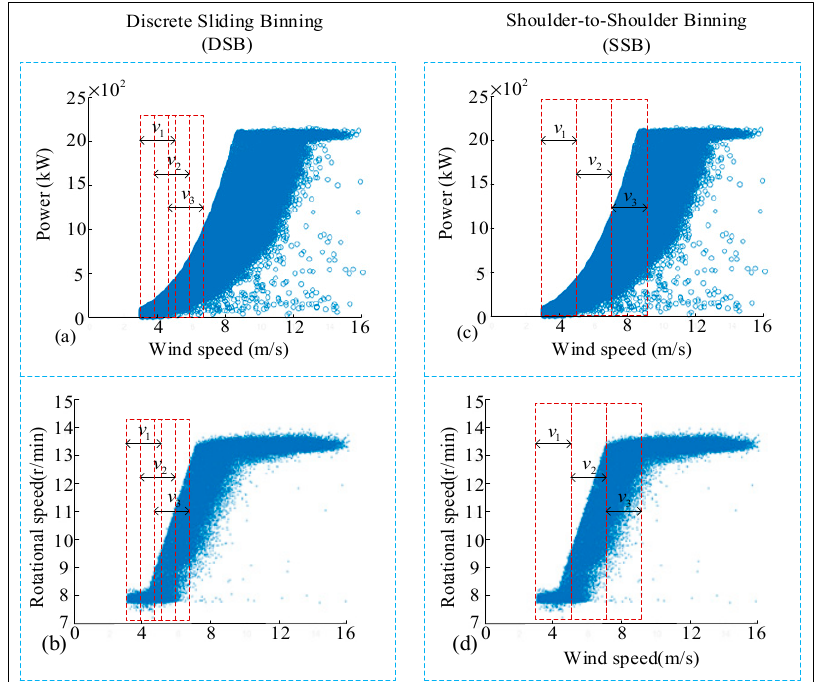
Figure 11. Di ff erent sliding Binning modes. ( a ) wind-power sca tt ed relationship obtained by DSB Figure 11. Different sliding Binning modes. ( a ) wind-power scatted relationship obtained by DSB mode; ( b ) wind-power sca tt ed relationship obtained by SSB mode; ( c ) wind speed and rotational mode; ( b ) wind-power scatted relationship obtained by SSB mode; ( c ) wind speed and rotational speed sca tt ed relationship obtained by DSB mode; ( d ) wind speed and rotational speed sca tt ed speed scatted relationship obtained by DSB mode; ( d ) wind speed and rotational speed scatted relationship obtained by SSB mode. relationship obtained by SSB